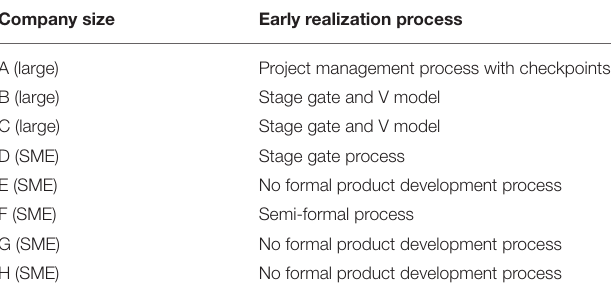
TABLE 2 | Company size and early realization process.